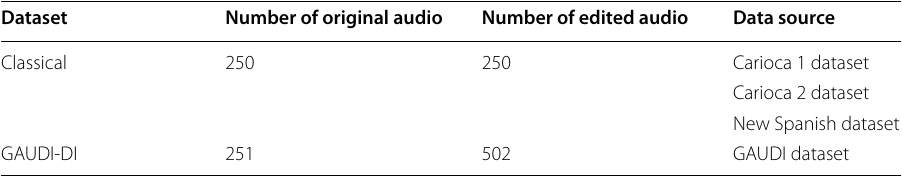
Table 1 Datasets used in the following experiments Dataset